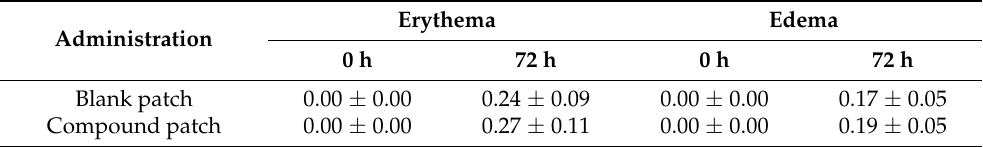
Figure 6. Skin irritation study for the LP-VPH compound transdermal drug delivery system showing ( A ) before application of the patch, ( B ) during the application of the optimized patch, and ( C ) after removal of the patch (n = 6). Table 4. Results of skin irritation (n =